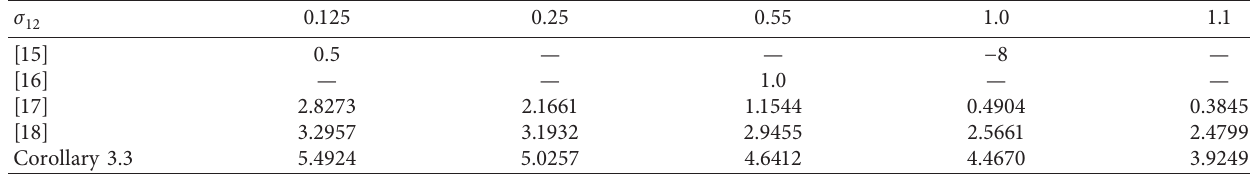
with different values of σ 2 12